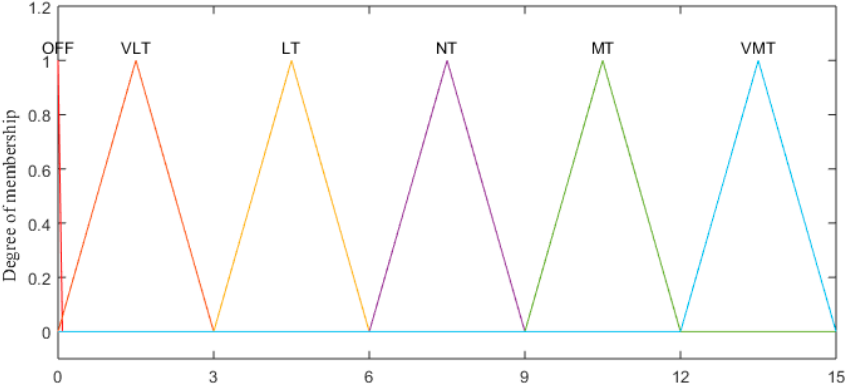
Figure 8. Membership function graph for actuators’ operational duration (min).